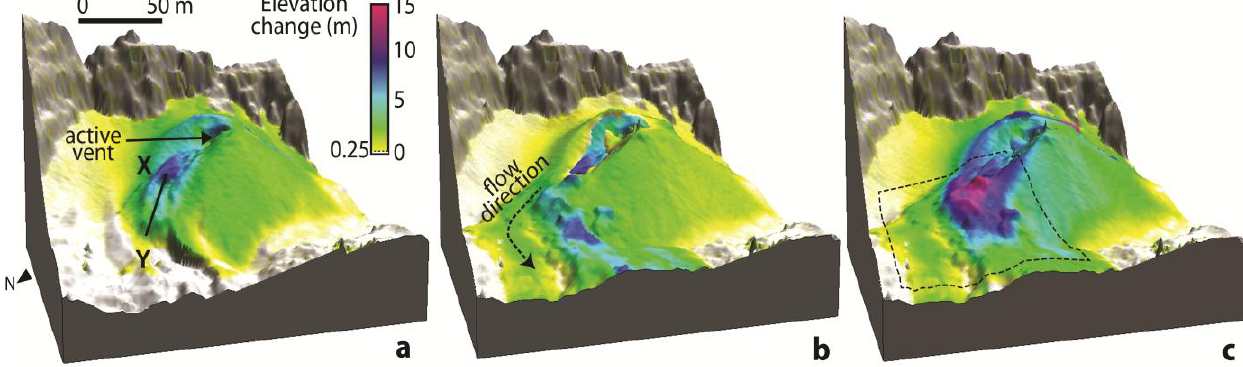
Figure 2. Elevation change in the full-cone DEMs for ( a ) 17–19 July, ( b ) 19–21 July and ( c ) 17–21 July. The perspective view is aligned looking southeast (as Figure 1b), with the lava flows in the foreground, effusing from a breach in the scoria cone. Sections of steep static topography in the background represent the lowest regions of the Bocca Nuova crater walls. In (c), the dashed outline illustrates the area of the DEM difference maps in Figure